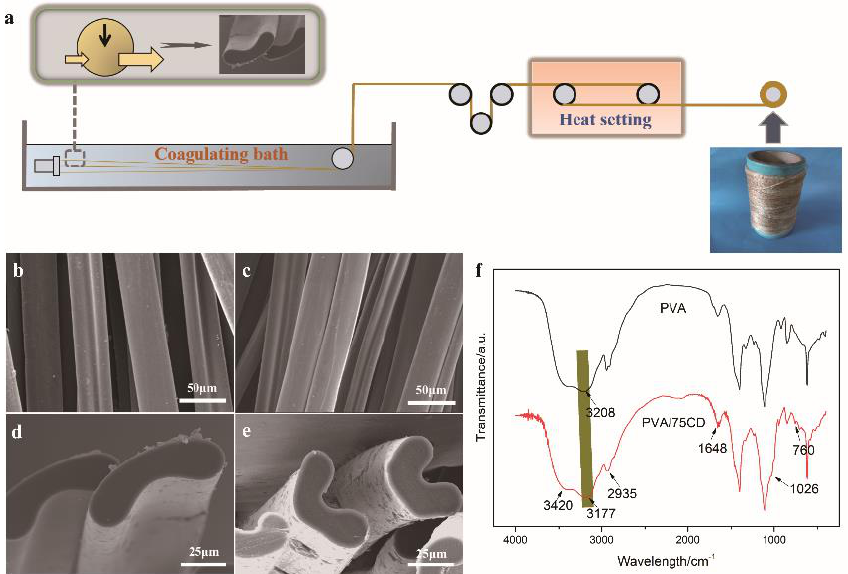
Figure 1. ( a ) Schematic illustration of the preparation of the composite fibers; ( b ). SEM image of the surface of PVA fibers; ( c ) SEM image of the surface of PVA/75CD fibers; ( d ) SEM image of the cross-section of PVA fibers; ( e ) SEM image of the cross-section of PVA/75CD fibers; ( f ) FTIR spectra of PVA and PVA/75CD fibers.